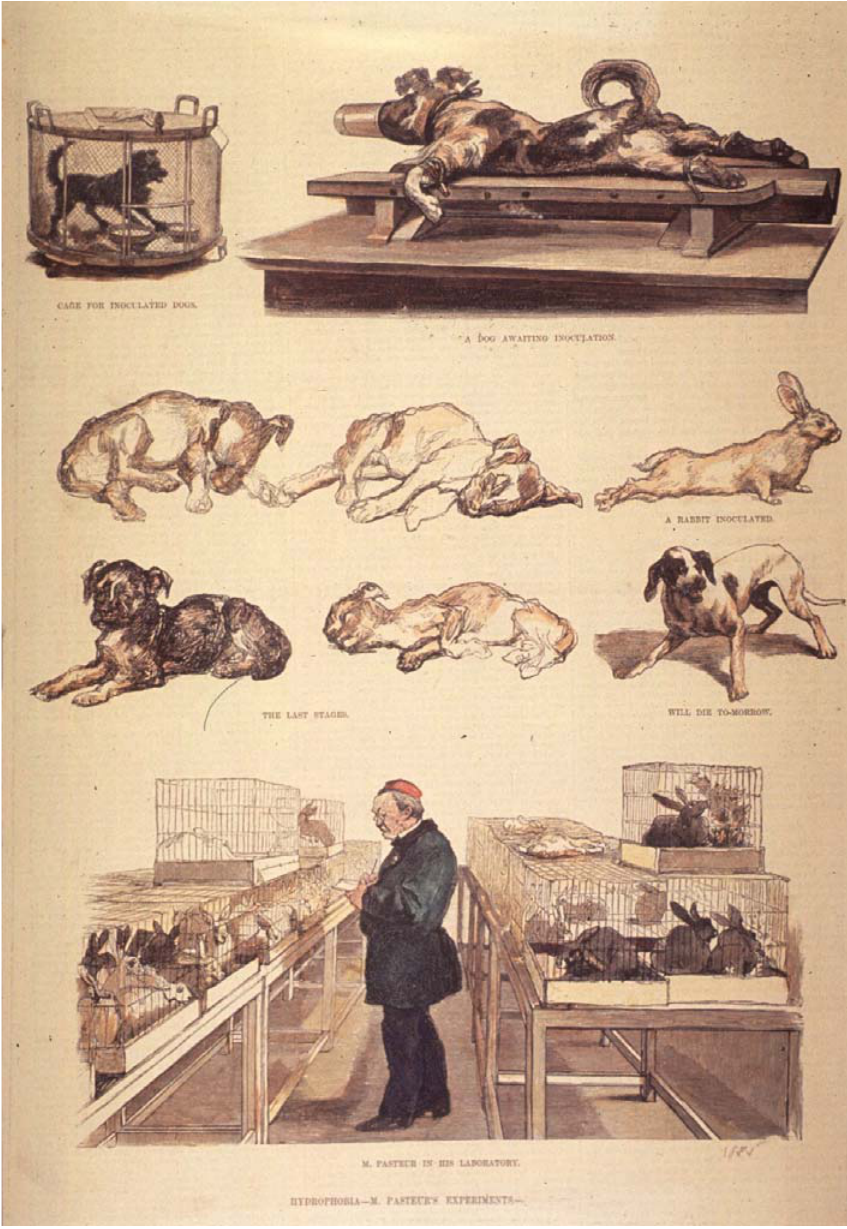
Figure 4. This full-page illustration of Pasteur in his animal facility was published in Harper’s Weekly in the United States, on 21 June 1884. At this time, there was moderate curiosity on Pasteur’s work in the US, which would intensify after his first successful human trials of a therapeutic vaccine for rabies in 1885. In the article, the reader is reassured that the use of dogs is both humane and justified in the interest of mankind. The use of other species, however, is barely mentioned [5]. Source: Images from the History of Medicine , U.S. National Library of